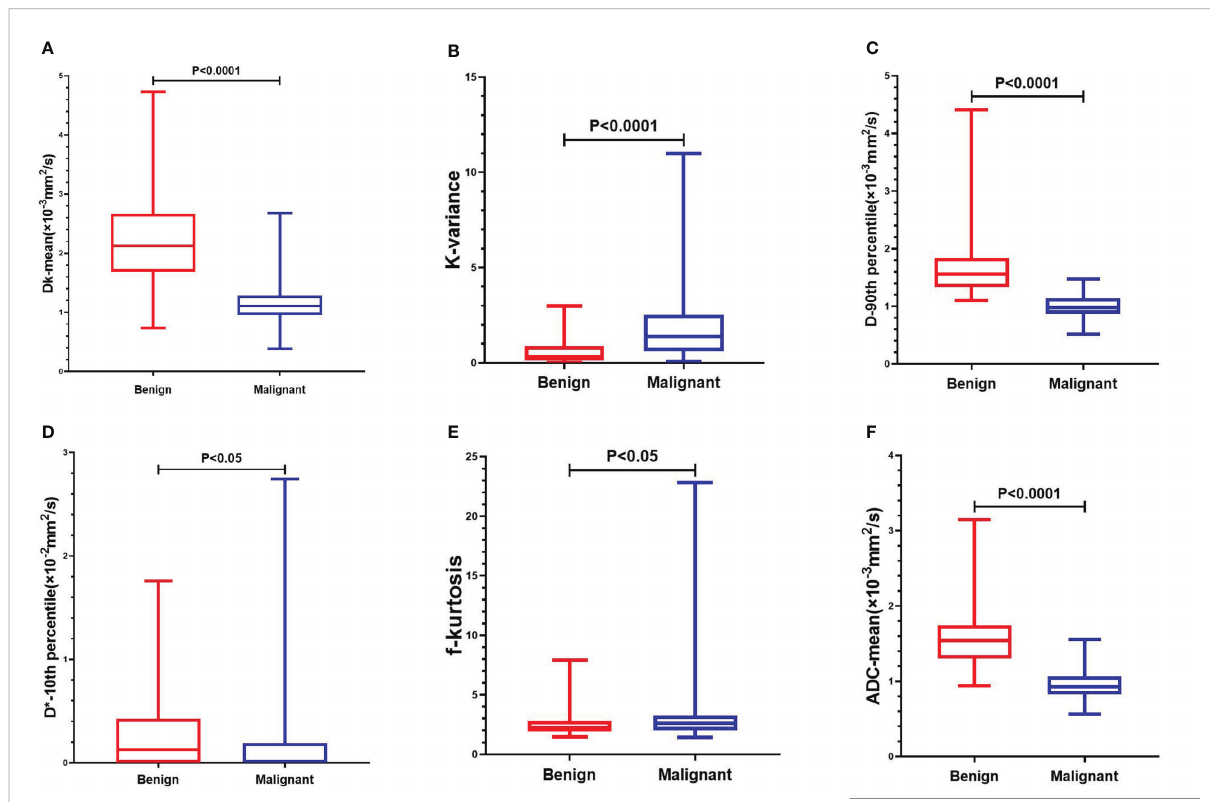
FIGURE 1 Comparison of whole-lesion histogram parameters of benign and malignant SPL. (A) : Dk-mean, (B) : K-kariance, (C) :D-90th percentile, (D) : D*- 10th percentile, (E) :f-kurtosis, (F) :